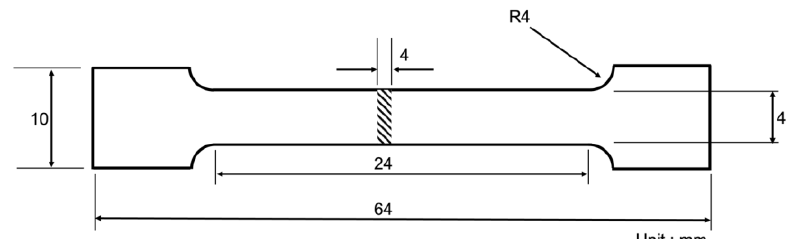
Figure 2. Schematic of a tensile test specimen.